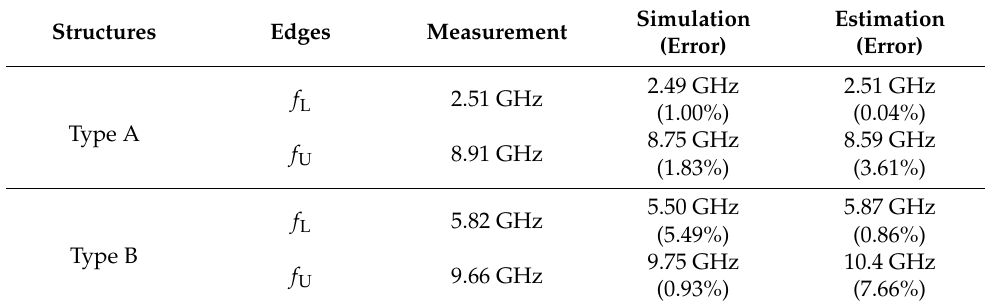
Table 3. Summary and comparison of measured, simulated, and estimated stopband edges.